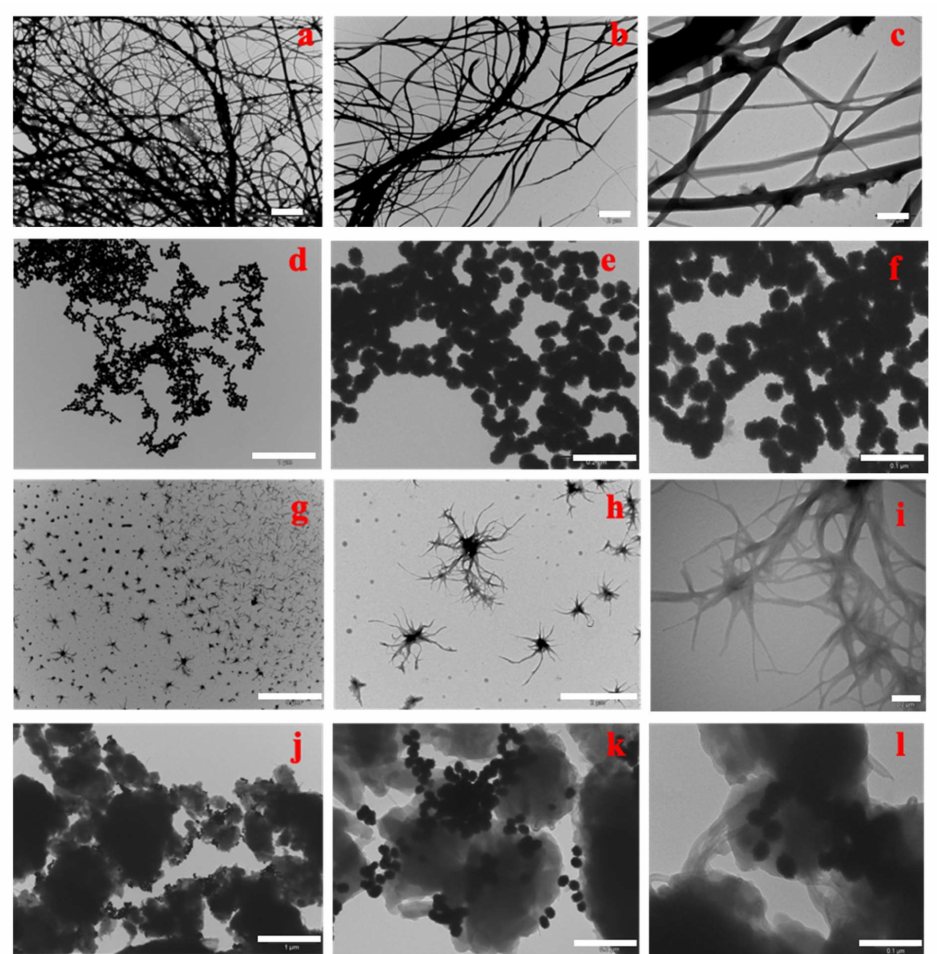
Figure 2. TEM images tPANI with different magnifications with scale bars indicating 5 µ m, 2 µ m and 0.5 µ m in ( a ), ( b ) and ( c ), respectively; Au@Pt core-shell nanoparticles with different magnifications with scale bars indicate 1 µ m, 0.2 µ m and 0.1 µ m in ( d ), ( e ) and ( f ) respectively. tPANI-MWCNT with different magnifications with scale bars indicating 5 µ m, 2 µ m and 0.2 µ m in ( g ), ( h ) and ( i ), respectively; and tPANI-Au@Pt -MWCNT with different magnifications with scale bars indicating 1 µ m, 0.2 µ m and 0.1 µ m in ( j ), ( k ) and ( l ),